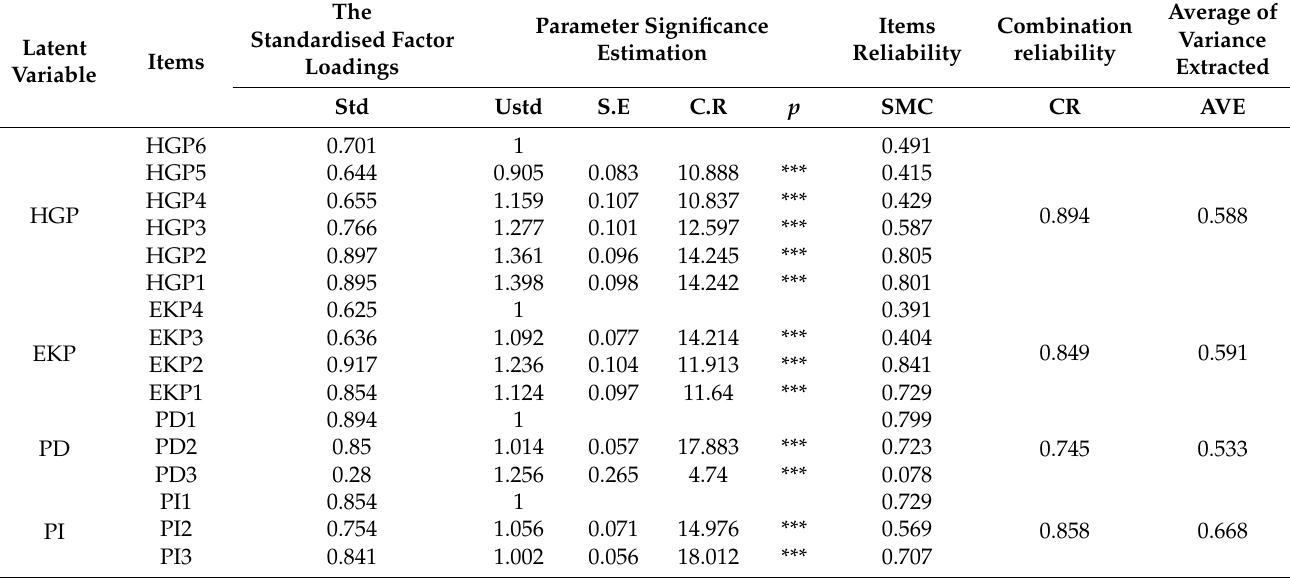
Table 5. Reliability and validity test. *** p <